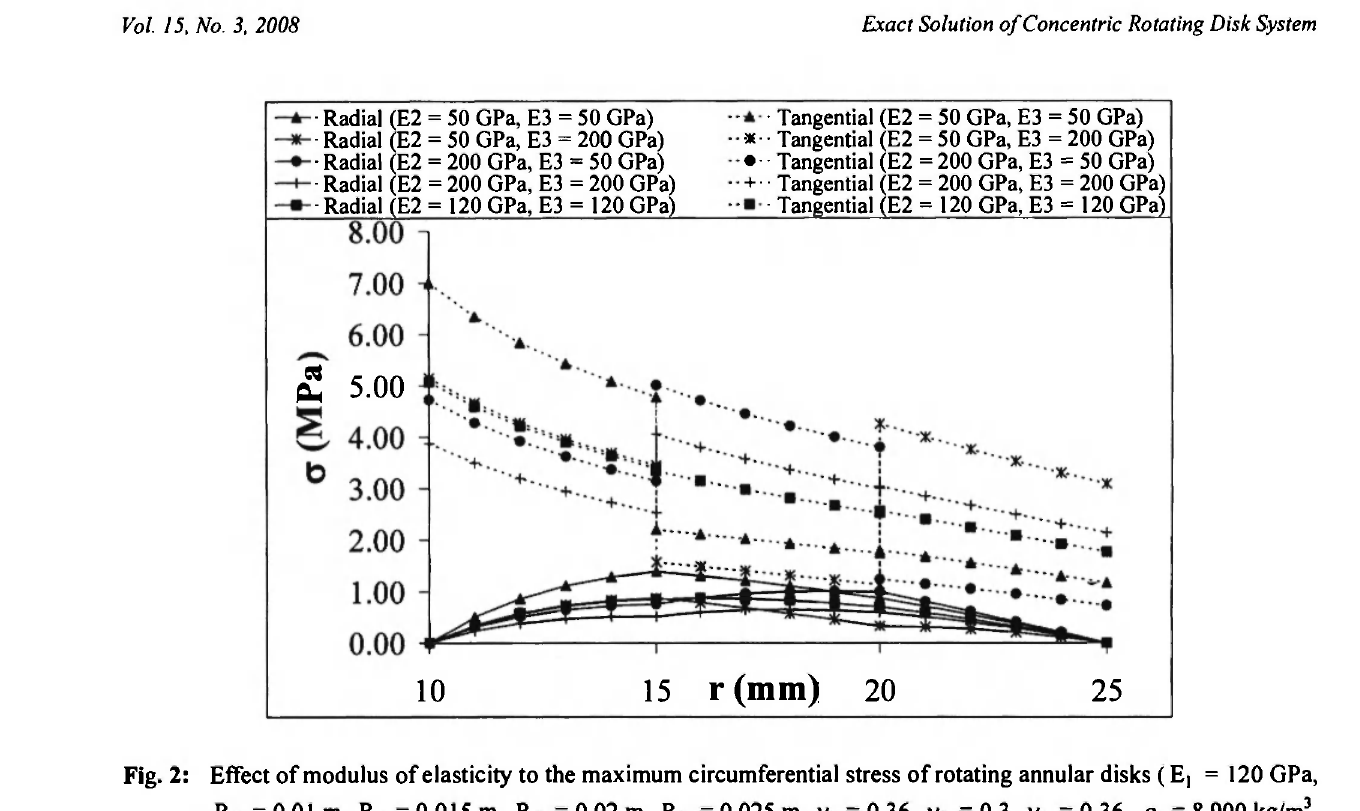
Fig. 2: Effect of modulus of elasticity to the maximum circumferential stress of rotating annular disks (E| = 120 GPa, R 0 = 0.01 m, R, = 0.015 m, R 2 = 0.02 m, R 3 = 0.025 m, v, = 0.36, v 2 = 0.3, v 3 = 0.36, p, = 8,900 kg/m 3 , P2 = 7,850 kg/m 3 , pj = 8,900 kg/m 3 , <y= 10,000 rpm).